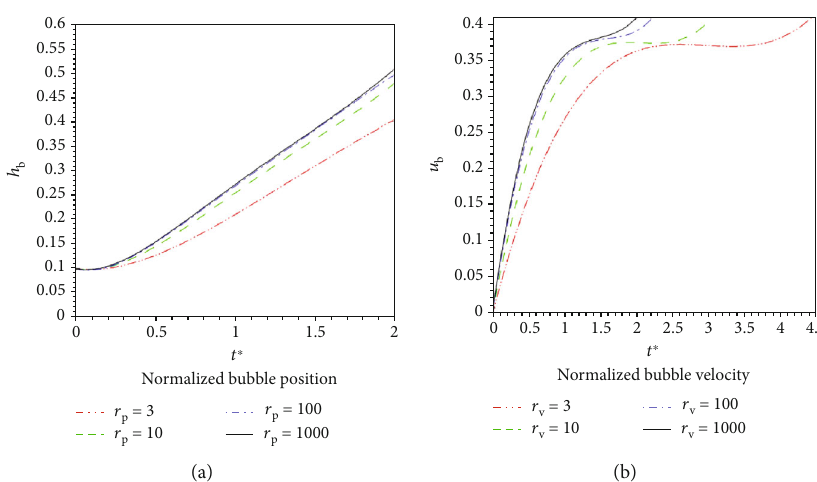
Figure 18: Temporal variations of the normalized bubble position and velocity for di ff erent density ratios ( Re = 10000 and r